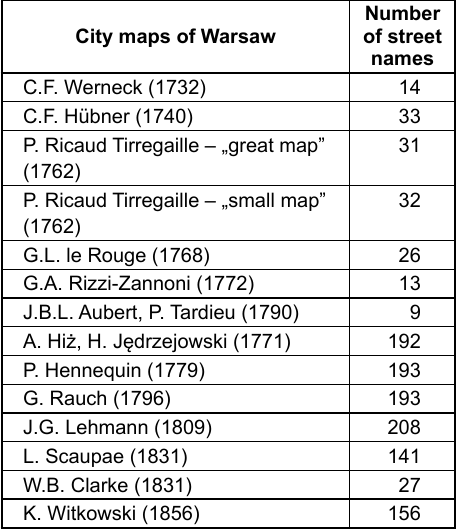
Table 1. The number of street names on selected